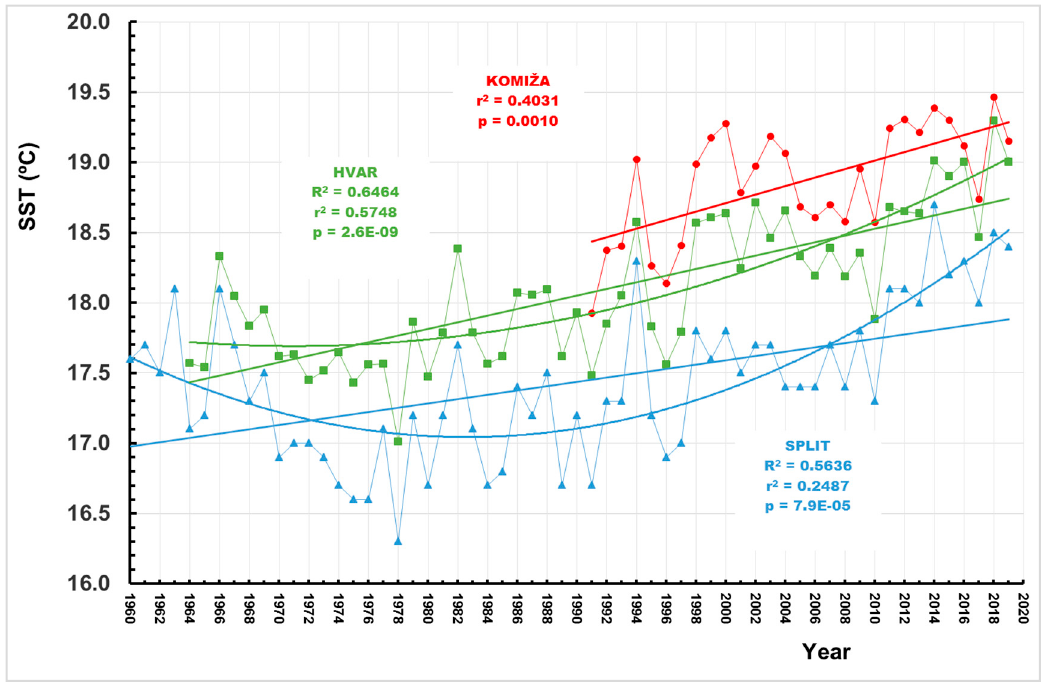
Figure 2. Time series of the mean annual SST measured at Split, Hvar, and Komiža stations. The r 2 and R 2 represent the r –squared values of the correlation coefficients of the linear and quadratic regressions, respectively, and p represents the Mann–Kendall (M–K) test values.